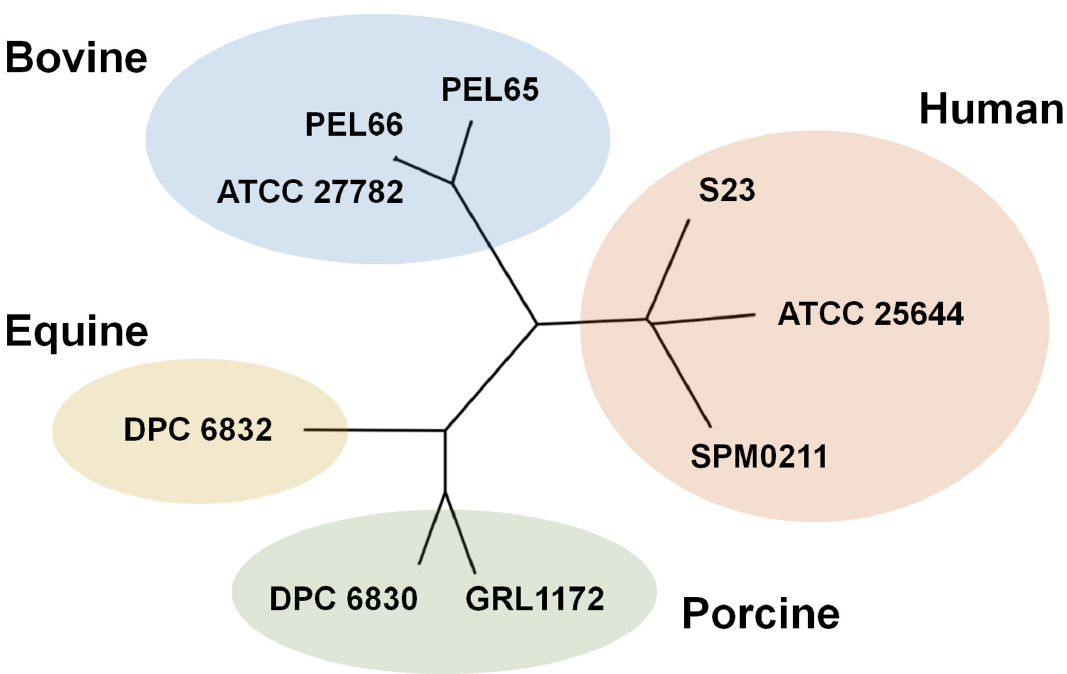
Fig 1. Phylogenetic tree analysis of the L . ruminis genomes. Unrooted phylogenies of the L . ruminis genomeswere basedon the multiplesequencealignmentof core proteins and constructed with the neighbor-joiningtree-building algorithm (see Materials and Methodsfor details). Names of the L . ruminis strains from which each genomeis derived are shown. Four distinct phyletic clades were identified based on host-gut source (human, bovine,porcine, or equine)and are indicated